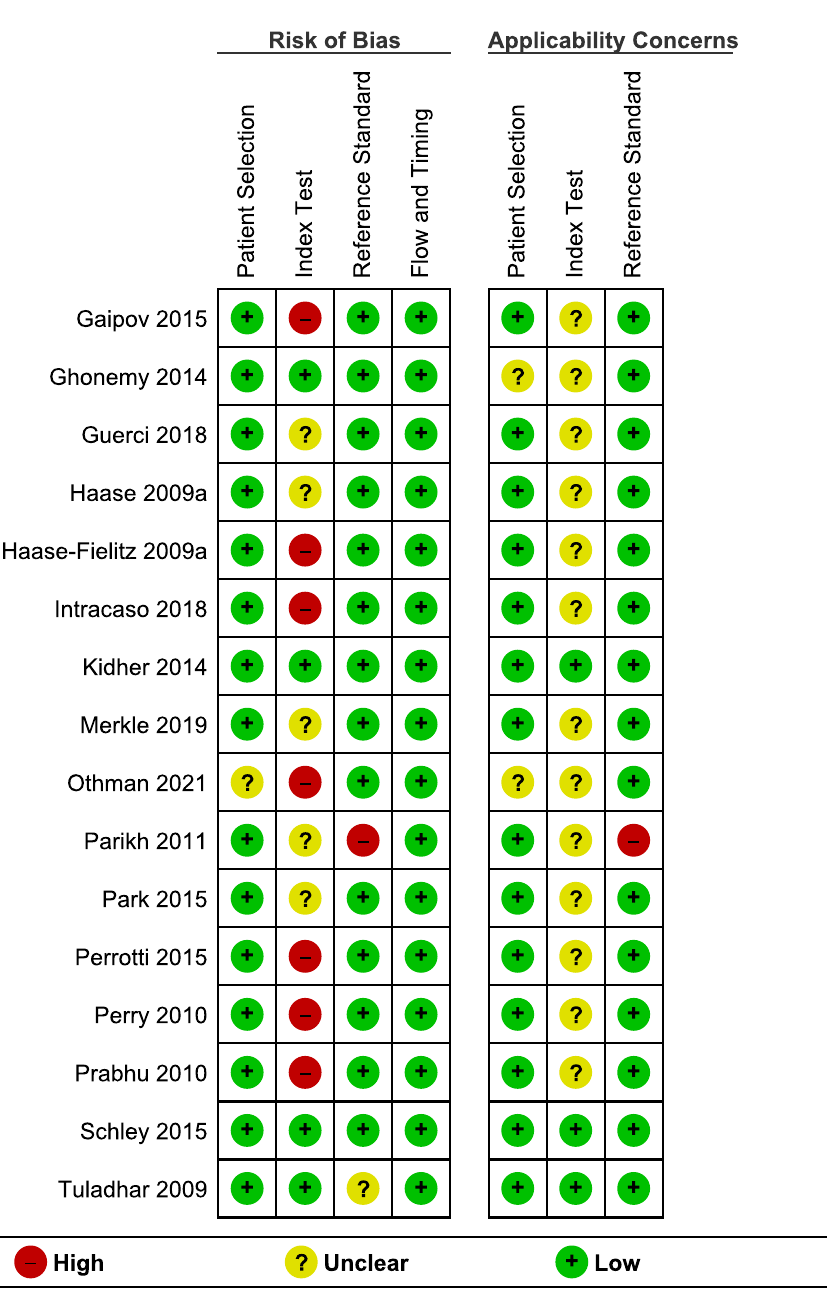
Figure 3. Risk of bias assessment using the QUADAS-2 tool: individual study